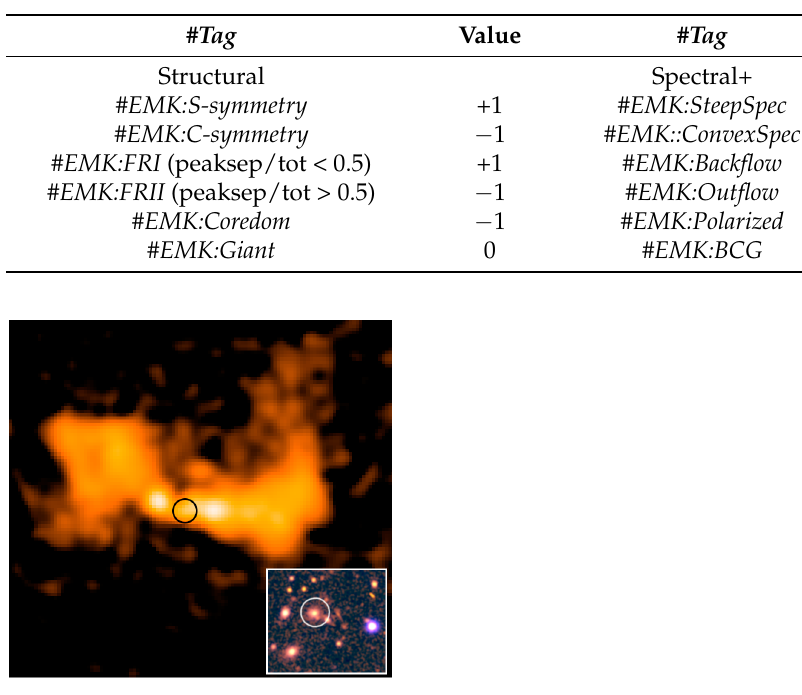
Figure 2. Anonymous example source from the (fictitious) EMK Survey for the application of # tag s. Radio map is actually from the MeerKAT Galaxy Cluster Legacy Survey Knowles et al. [4]. Optical inset is from the Dark Energy